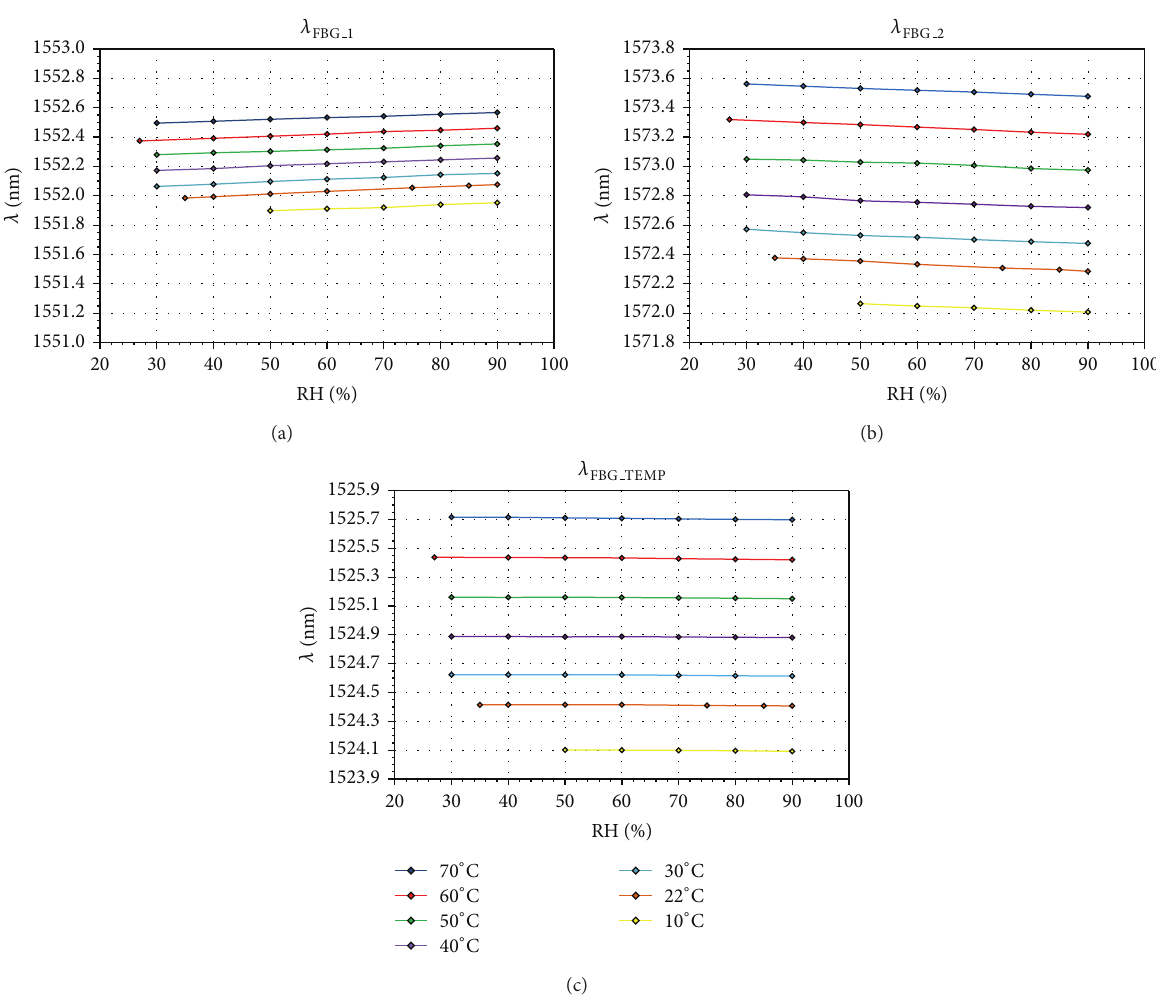
Figure 8: Linear fit to the Bragg wavelength shift with the RH for (a) FBG 1, (b) FBG 2, and (c) FBG TEMP.